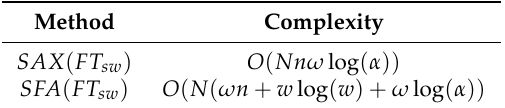
Table 3. Complexity of Bag-of-patterns using SAX and SFA